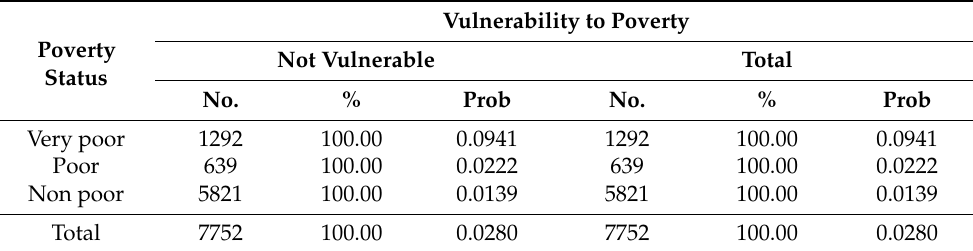
Table 7. Vulnerability without Social Expenditure, 2005/2006.